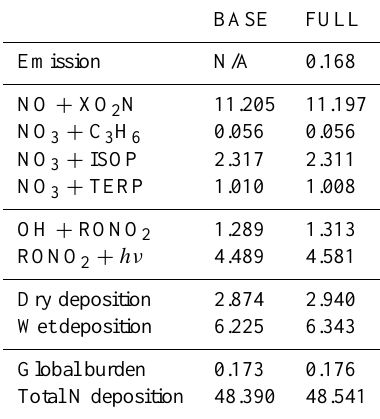
Table 4. The annual tropospheric chemical budget terms for RONO 2 for 2008 as calculated in the modified CB05 chemical mechanism as given in TgNyr − 1 for selected TM5 simulations. The term for total nitrogen deposition is defined as the sum of dry and wet deposition of NO 2 , HNO 3 , RONO 2 and PAN.